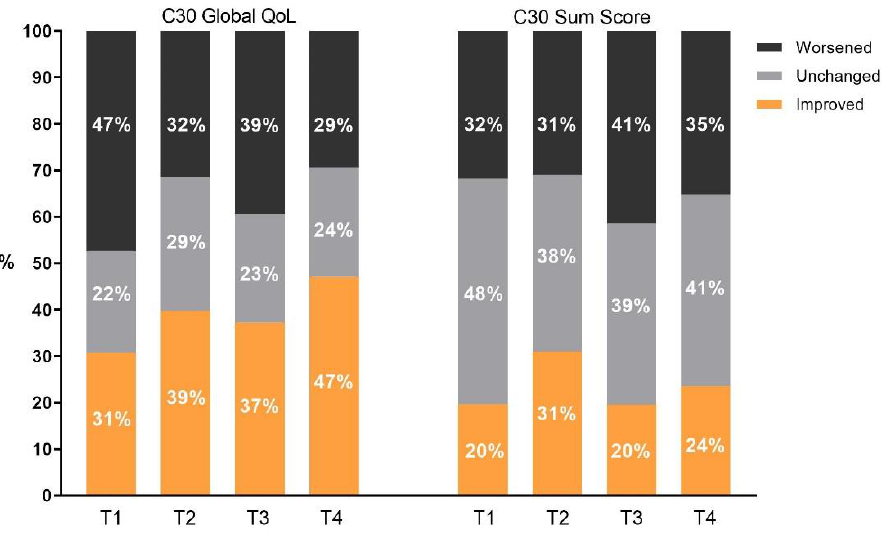
Figure 2. EORTC QLQ-C30 global QoL and C30 SumSc. The histogram shows the relative change in scores at T1 T1 (directly after PT), T2 (1-year follow-up), T3 (2-year follow-up) and T4